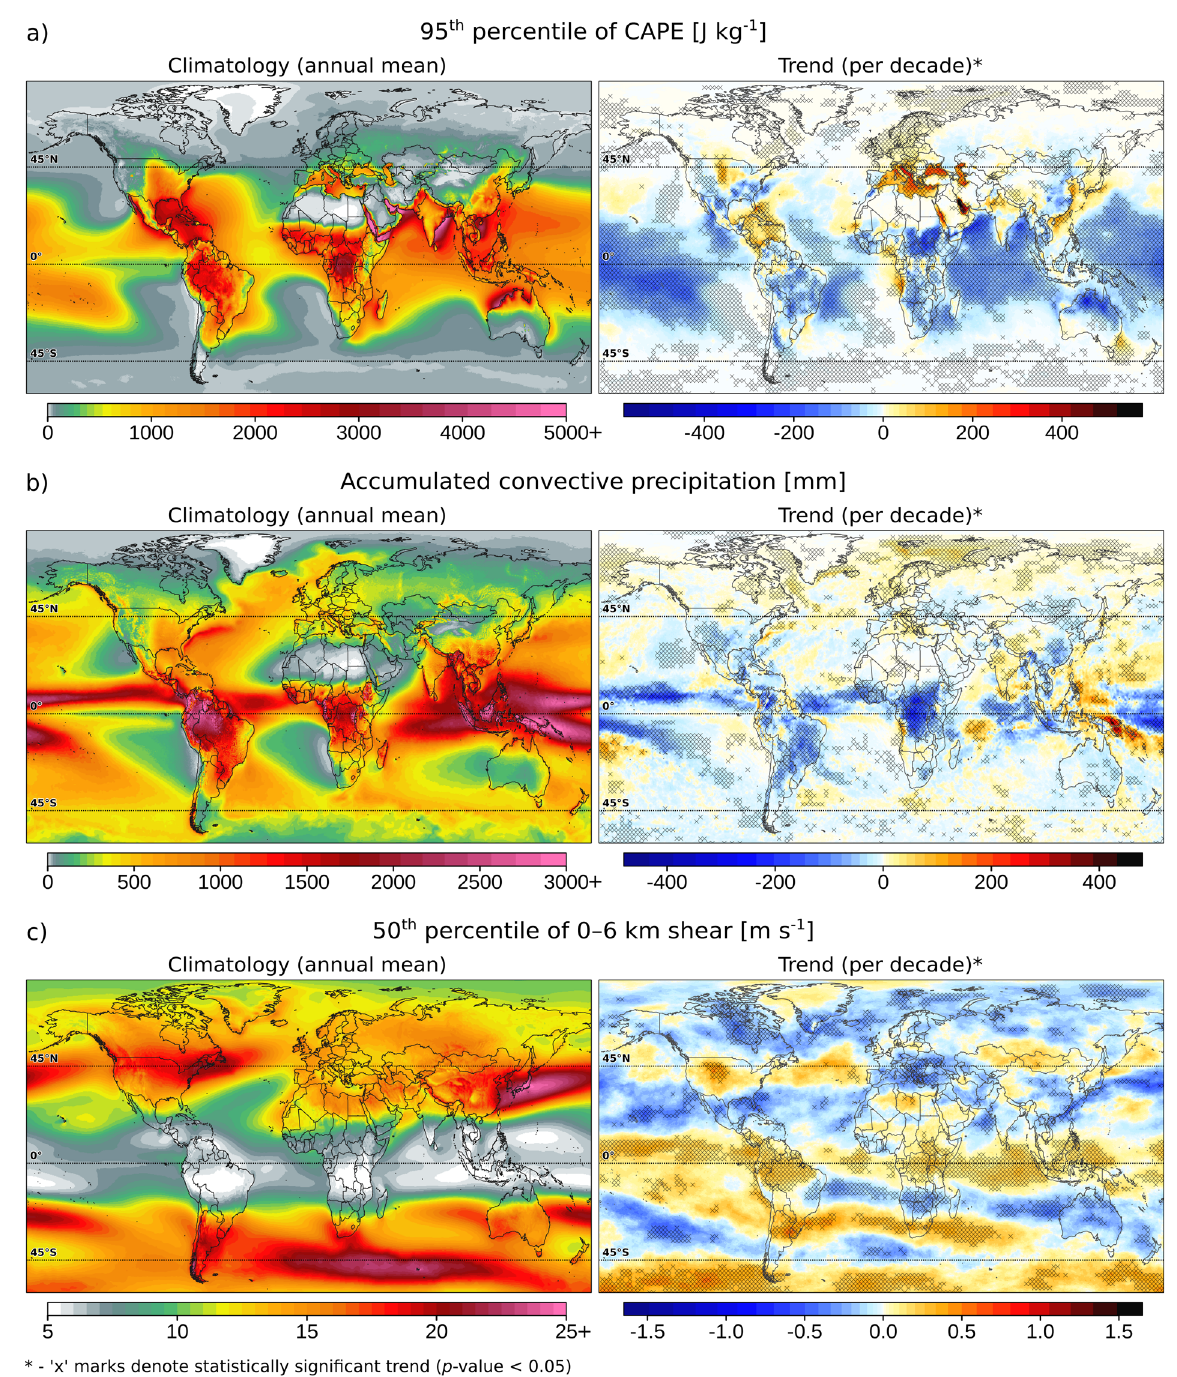
Fig. 1 ERA5 climatology and trends for CAPE, convective precipitation and vertical wind shear. A 41-year (1979 – 2019) climatology and trends for the ( a ) 95 th percentile of convective available potential energy (CAPE), ( b ) accumulated convective precipitation, and ( c ) 50 th percentile of 0 – 6 km vertical wind shear. Climatology is constructed by taking a mean from annual values, and trends are computed using Sen ’ s slope (values denote change per decade). Statistically signi fi cant trends ( p -value < 0.05) are marked with ‘ x ’